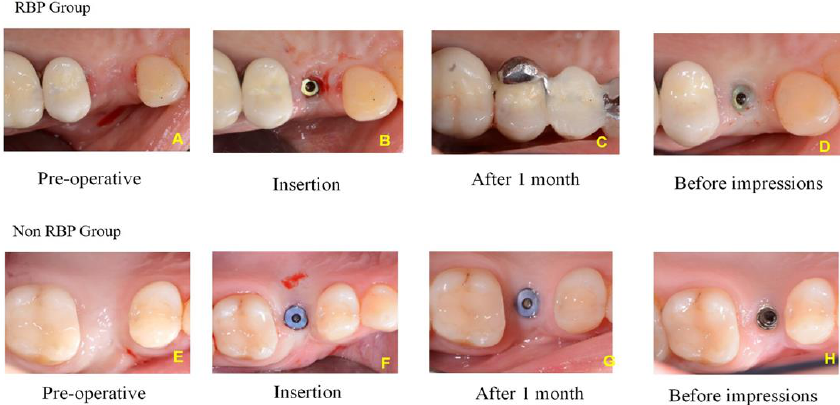
Figure 5. Clinical images of 2 different cases. RBP group: ( A ) Clinical case from protected group. Insertion of a 3.8 mm implant to replace a right upper premolar. ( B ) A flapless surgery and a tissue- level implant placement was performed. ( C ) The resin-bonded prosthesis was placed and maintained for 3 months. ( D ) At the moment of impression procedures, RBP was easily removed. Please note the absence of plaque accumulation and the soft tissues overgrowth over the cover screw. The morphology of tissue appeared stable. Non-RBP group: ( E ) Clinical case from non-protected group. A 4.25 mm implant was placed within 2 months from tooth extraction of a fractured upper premolar. ( F ) A flapless surgery and a tissue-level placement was performed. ( G ) No RBP was